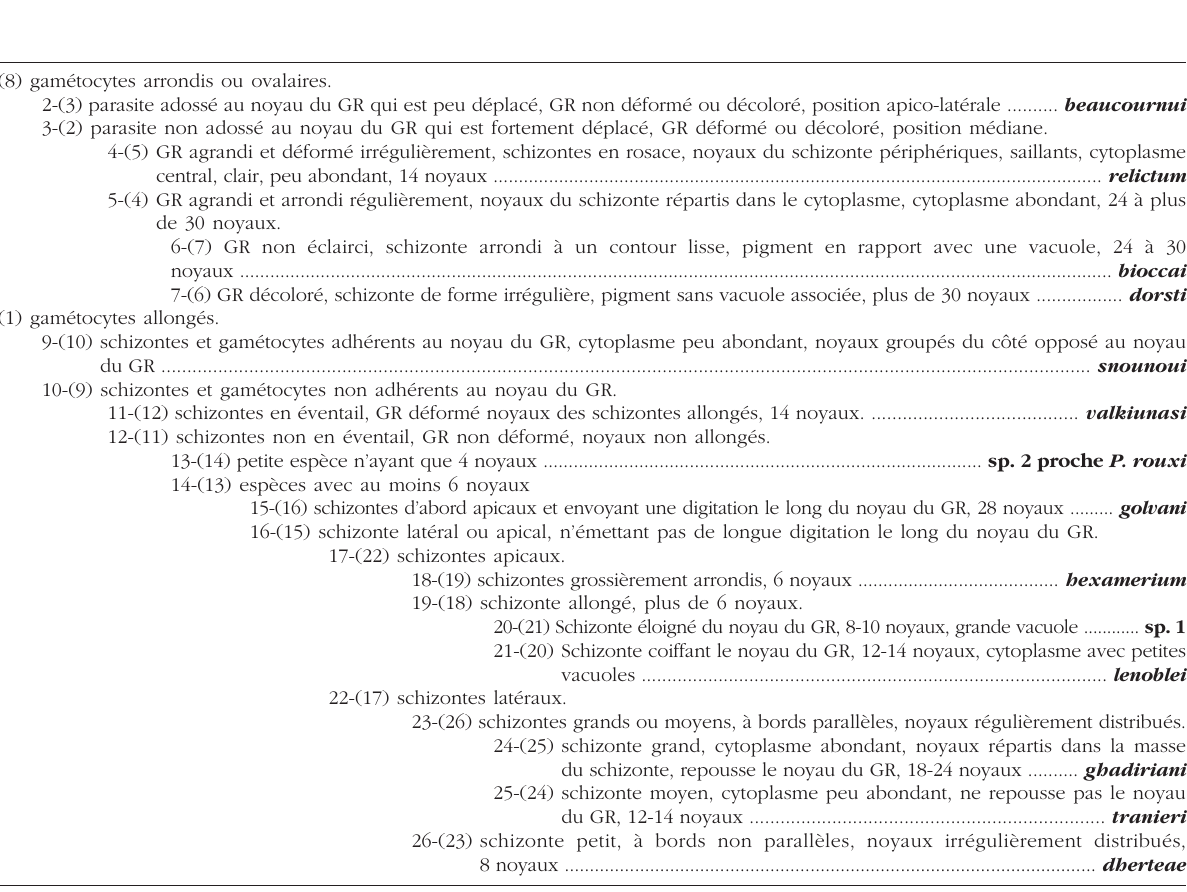
Tableau I. – Tableau dichotomique des espèces identifiées chez Pica pica